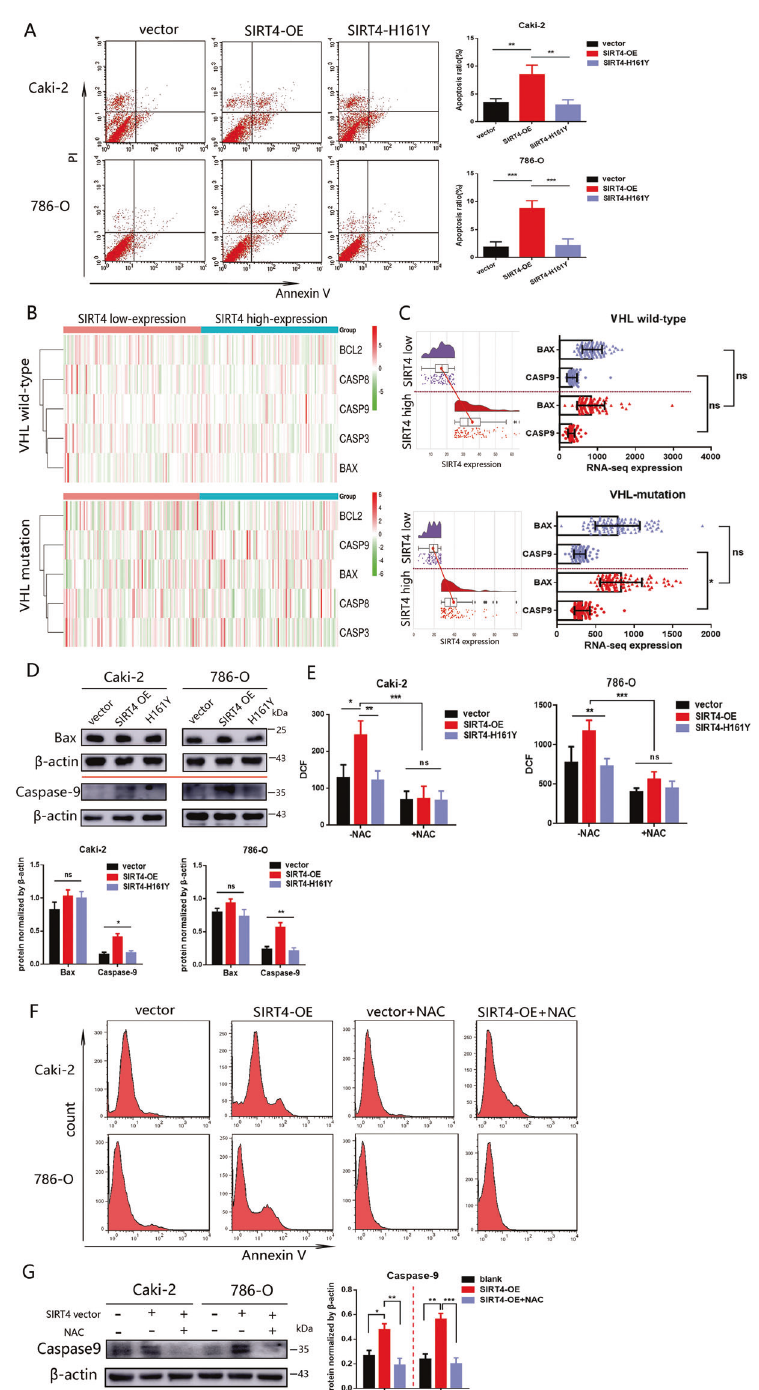
Fig. 4 SIRT4-OE induced apoptosis by ROS enhancement. A The effect of SIRT4-OE and H161Y reconstitution on apoptosis was evaluated in Caki-2 and 786-O cells. Apoptosis (cells with annexin V positive) ratio was revealed as right. B Clustering heatmaps were performed based on the expression of SIRT4 and apoptosis-related genes (BCL2, CASP8, CASP9, CASP3, BAX) from the TCGA database. C Expression differences of CASP9 (caspase-9) and BAX between SIRT4-low and SIR4-high-expression subgroups based on the TCGA database ( Nature , 2013). Data are plotted as means ± SD. D Protein expression levels of caspase-9 and Bax in Caki-2 and 786-O cells with SIRT4 overexpression or H161Y reconstitution. Densitometric analysis of western blots was exhibited underneath. After treating cells with NAC at a dose of 5 mM for 24 h, intracellular ROS levels were determined by DCFDA (DCF) staining ( E ), and apoptosis was determined by FACS ( F ). G Assess the effects of SIRT4 overexpression and NAC on protein caspase-9 expression by western blot. Densitometric analysis of caspase-9 is shown on the right panel. Throughout the fi gure, * P < 0.05, ** P < 0.01, *** P < 0.001, ns: no signi fi